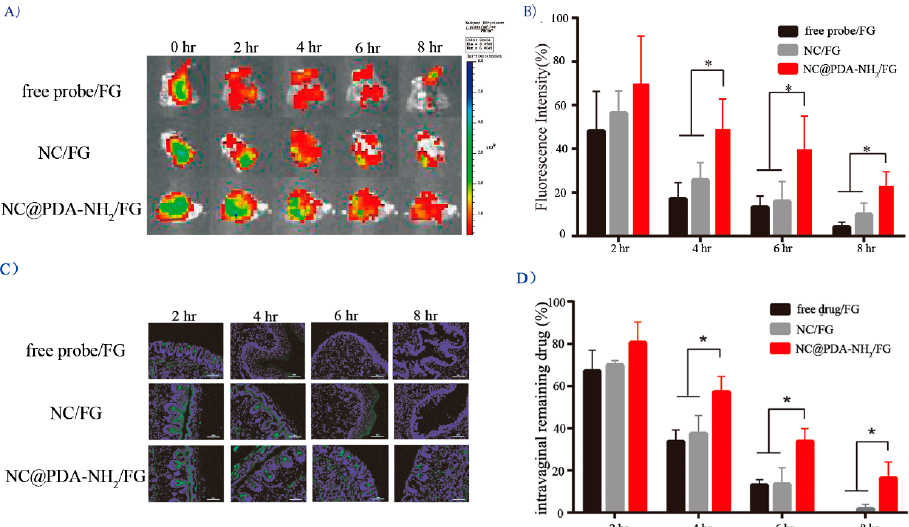
Figure 5. Ex vivo mucoadhesiveness and in vivo placement. ( A ) Typical fluorescent images, and ( B ) semi ‐ quantitative fluorescent intensity ( n = 6, mean ± SD) for the ex vivo residence of 1,1 ′‐ dioctadecyl ‐ 3,3,3 ′ ,3 ′‐ tetramethylindotricarbocyanine iodide (DiR) ‐ labeled NC@PDA ‐ NH 2 /FG, NC/FG, or free probe DiR/FG on the surface of ex vivo vaginal mucosa of healthy mice during flushing by VFS at 37 °C. ( C ) Fluorescent microscopic images (green signal for C6, blue signal for DAPI; scale bar = 100 μ m), and ( D ) intravaginal residence percentage of imatinib in healthy mice vaginally administered with NC@PDA ‐ NH 2 /FG, NC/FG, or free imatinib/FG ( n = 6, mean ± SD); * indicates p < 0.05.